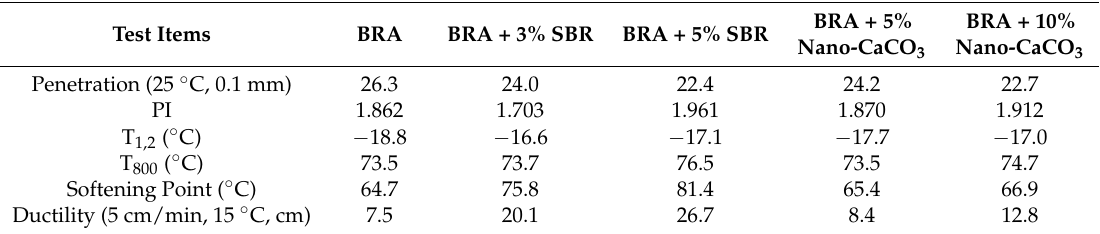
Table 5. The basic technical properties of modified